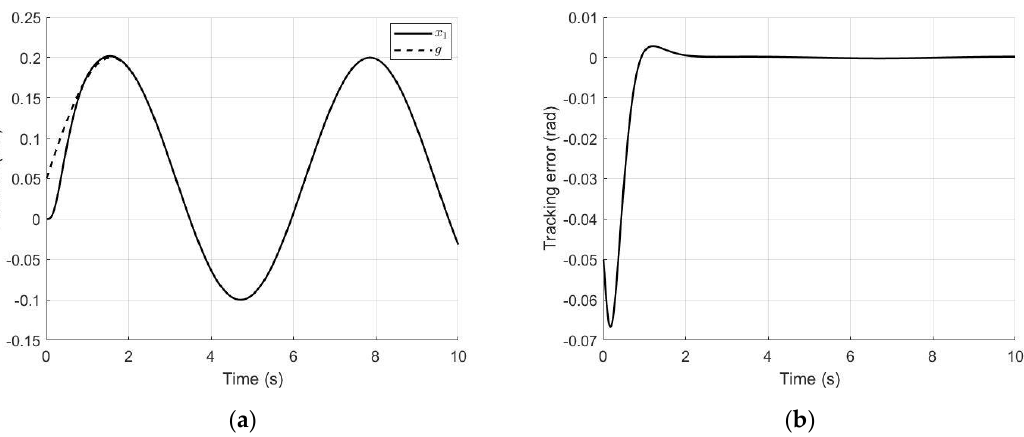
( ) x t ; in ( b ), plot 1